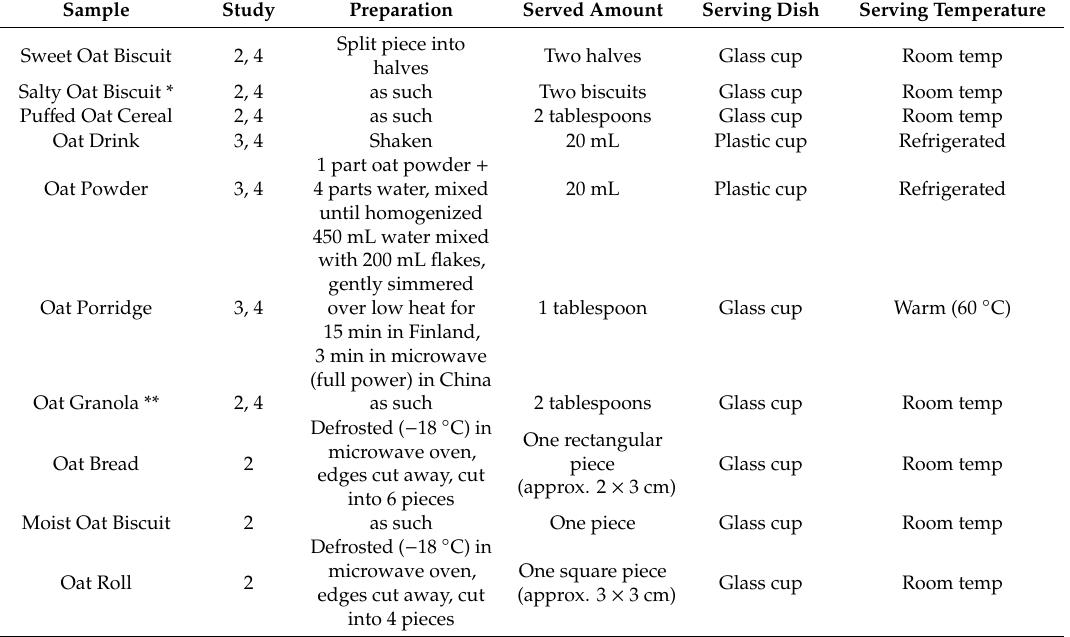
Table 2. Oat samples, their preparations, served amounts and serving conditions in the sensory tests in Finland and